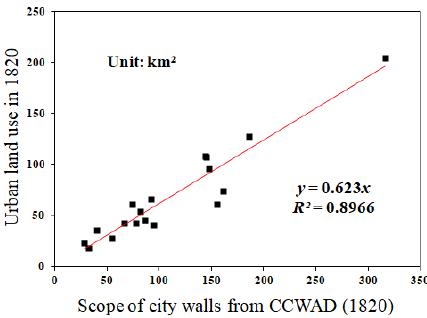
Figure 8. Comparison of the area of urban land use in 1820 (ULUD) from He et al. (2002) and the area of the extent of city walls in 1820 from